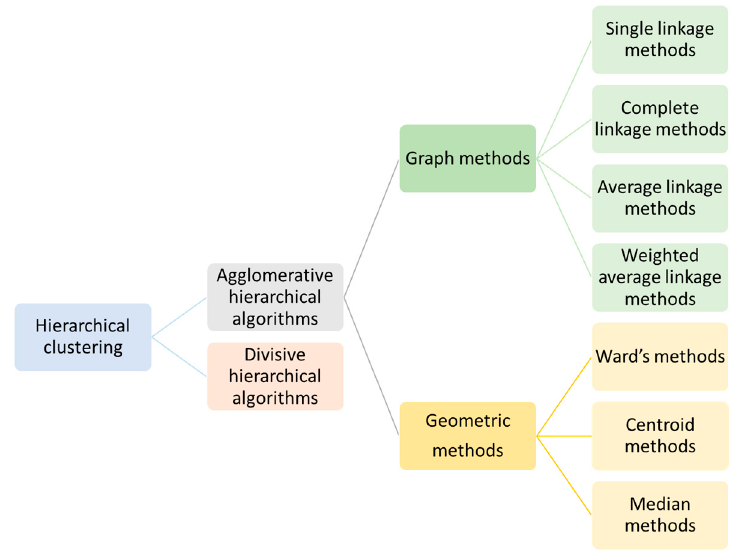
Figure 4. An overview of hierarchical clustering methods [27].